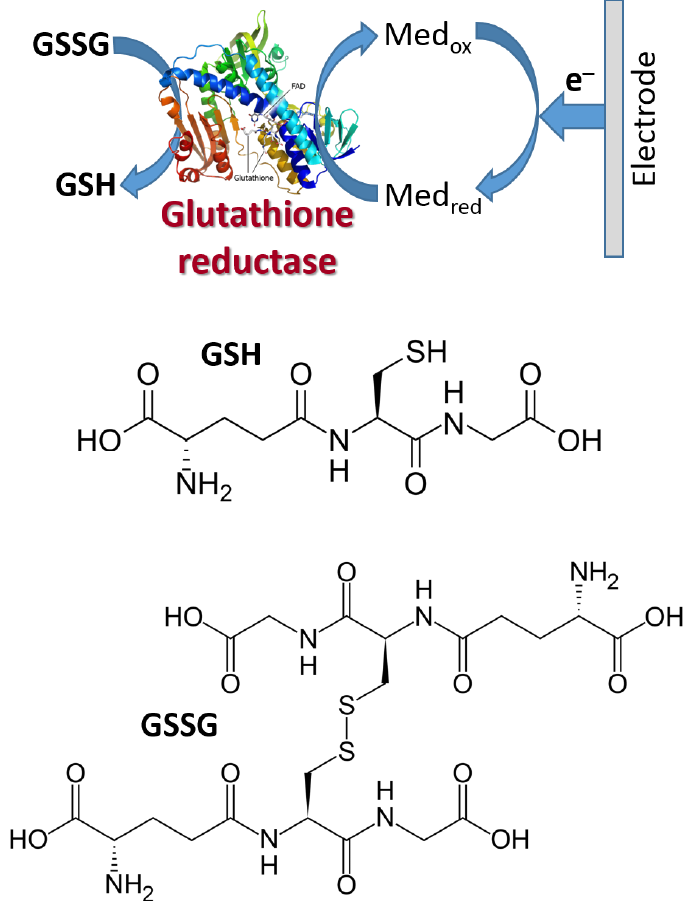
Figure 18. Example of mediated reductive bioelectrocatalysis.